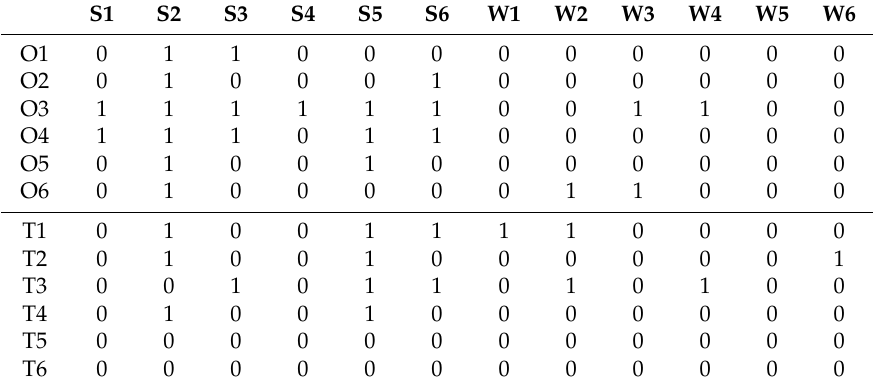
Table 8. TOWS analysis of interrelationships. Source: own study.